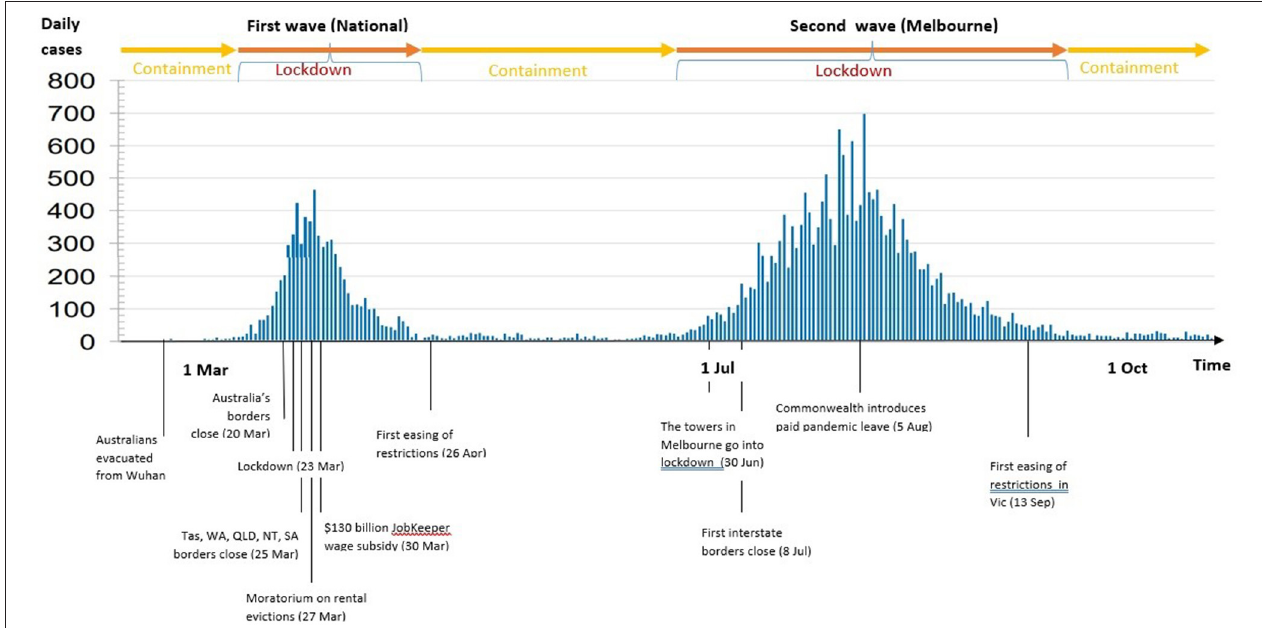
FIGURE 2 | Timeline of COVID-19 cases reported in Australia (Infogram, 2021). Adapted from Duckett and Stobart